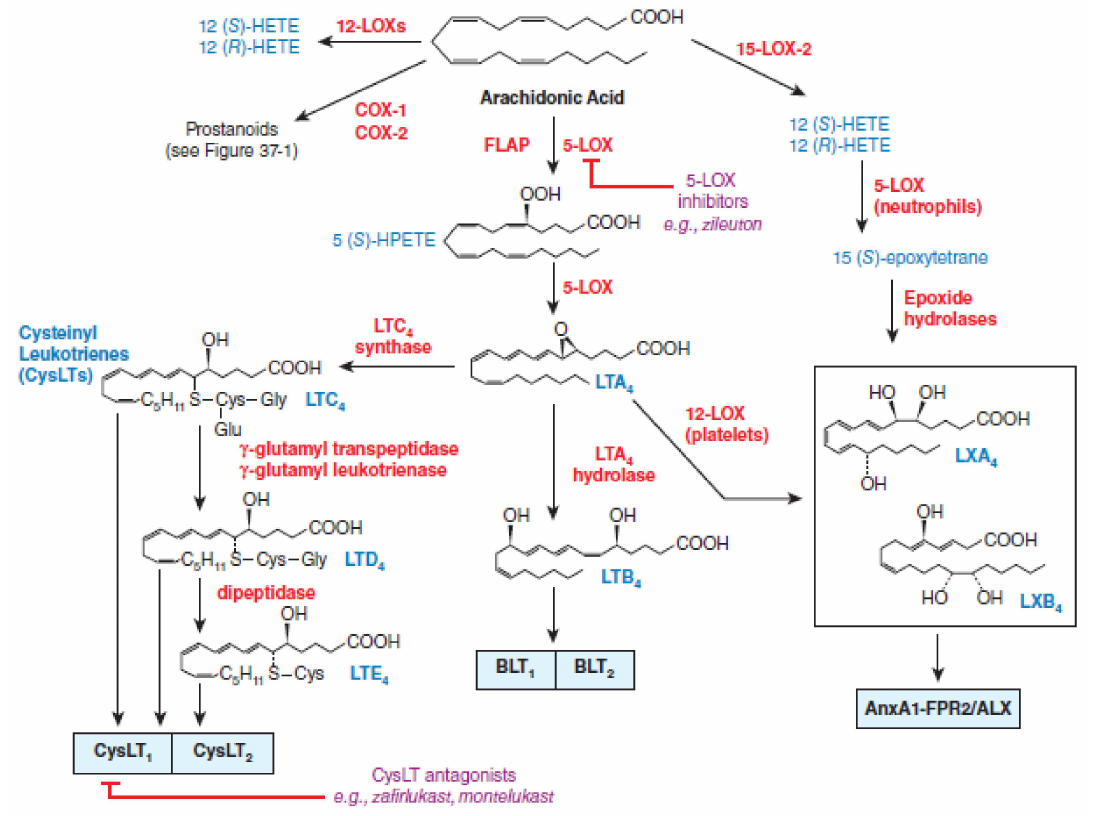
Figure 2. Lipoxygenase pathways of AA metabolism. With permission of Mc Graw